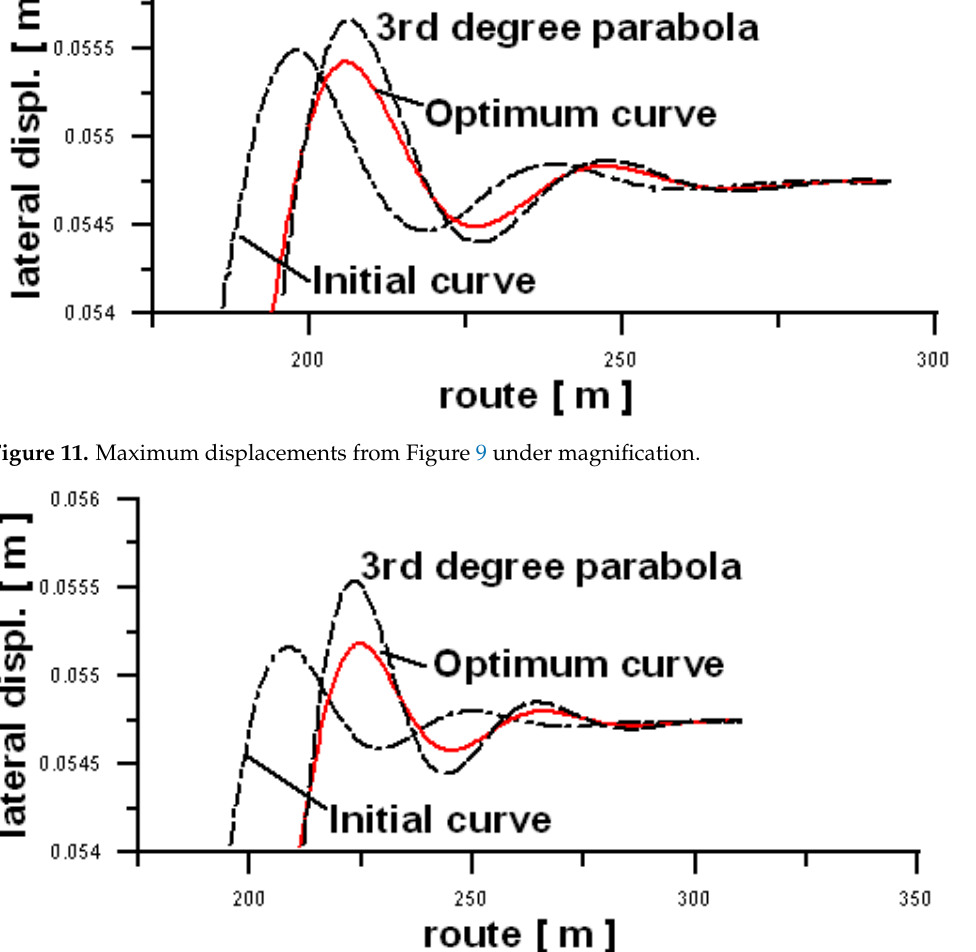
Figure 12. Maximum displacements from Figure 10 under magnification.